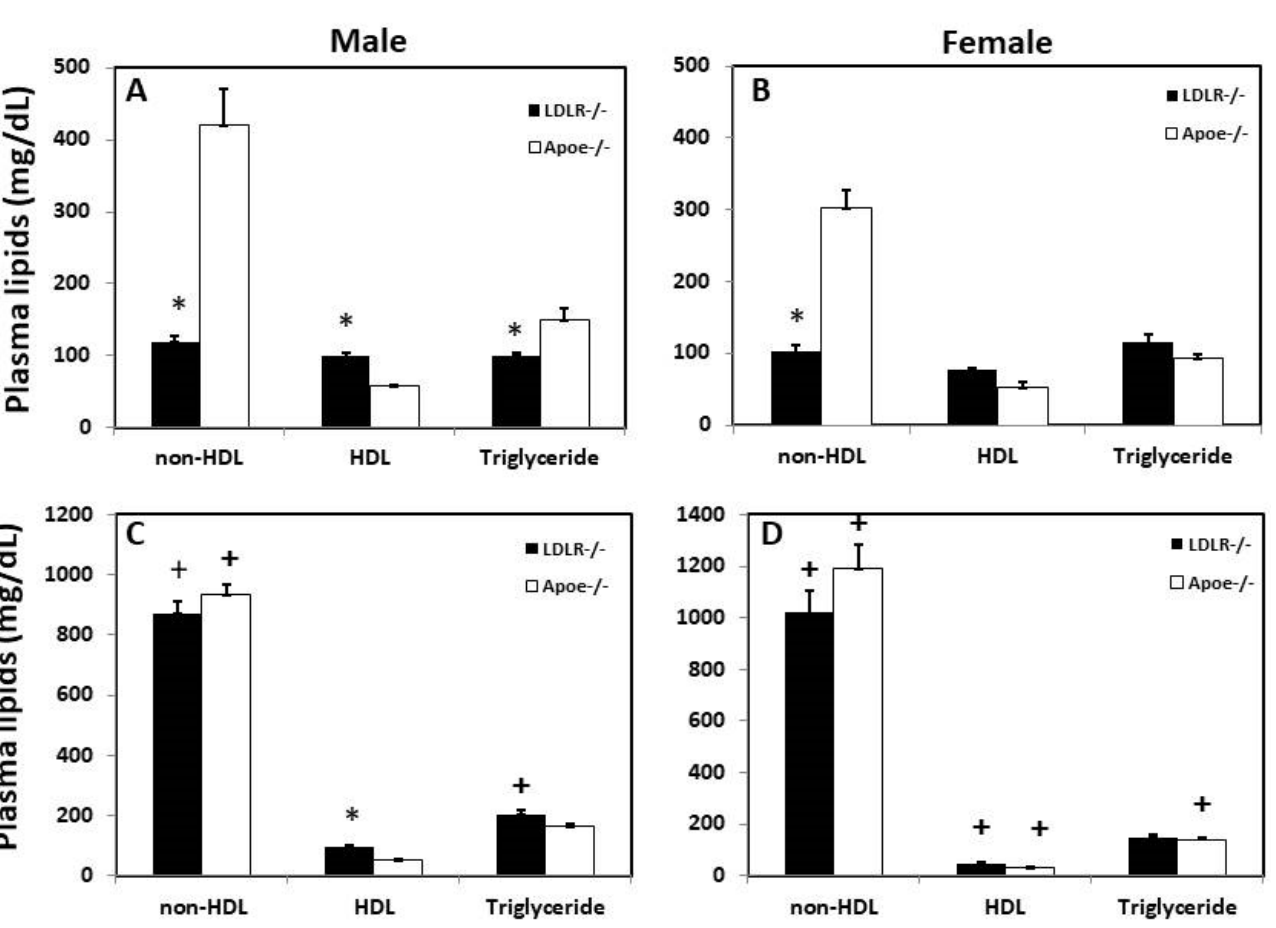
Figure 2. Fasting plasma levels of non-HDL, HDL cholesterol, and triglyceride in male and female C3H- Apoe -/- and C3H- Ldlr -/- mice fed a chow ( A , B ) or Western diet ( C , D ). Results are means ± SE of 4 to 29 mice per group. * p < 0.05 vs. Apoe -/- mice; + p < 0.05 vs. chow diet. C3H- Ldlr -/- and C3H- Apoe -/- mice had similar plasma triglyceride levels except for males on the chow diet, with the former being significantly lower (100.1 ± 4.2 vs. 150.4 ± 15.3 mg/dL; p = 0.00018; n = 4 to